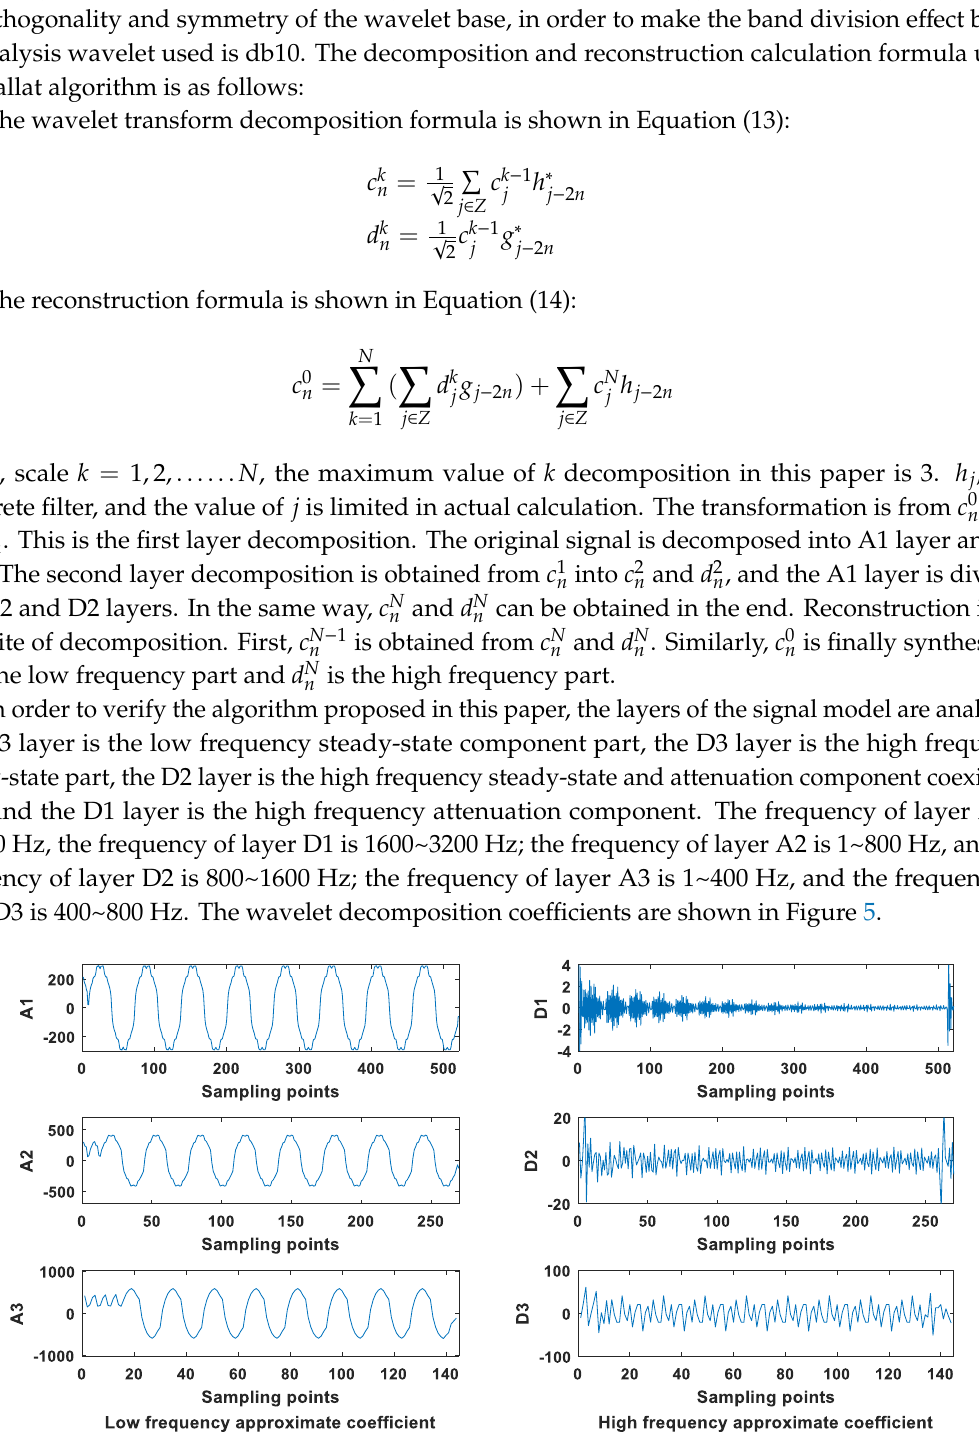
ffi cients and high frequency coe ffi cients of the signal S ( t ) Figure-5. Low frequency coefficients and high frequency coefficients of the signal ( ) S t . Figure 5. Low frequency coe